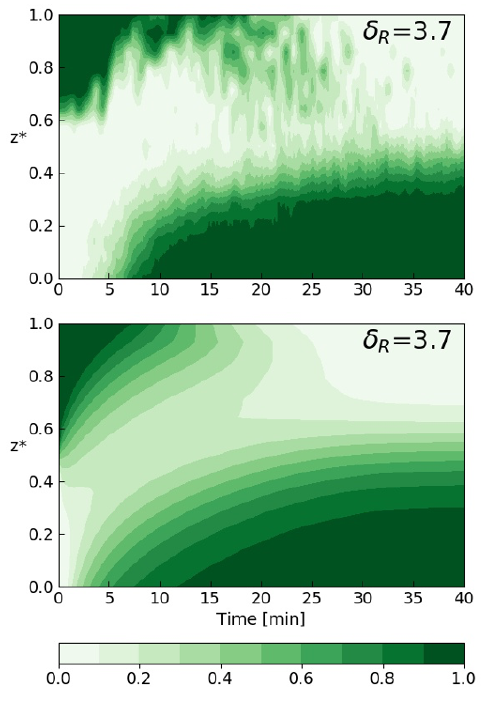
Fig. 5. Experimental measurement (on top) and a numerical simulation (on bottom) of the heavy particle concentration distribution for 𝛿 3 = 1.40 .